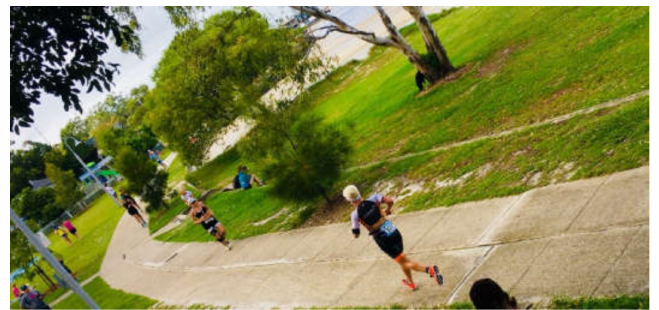
Figure 6. Running stage of an Ironman event 42.2 km, Taupo New Zealand (38.7 ◦ S 176.1 ◦ E) 3 March 2018. This stage typically takes the longest amount of time to run in a triathlon but provides good opportunity for event organisers to make use of shaded